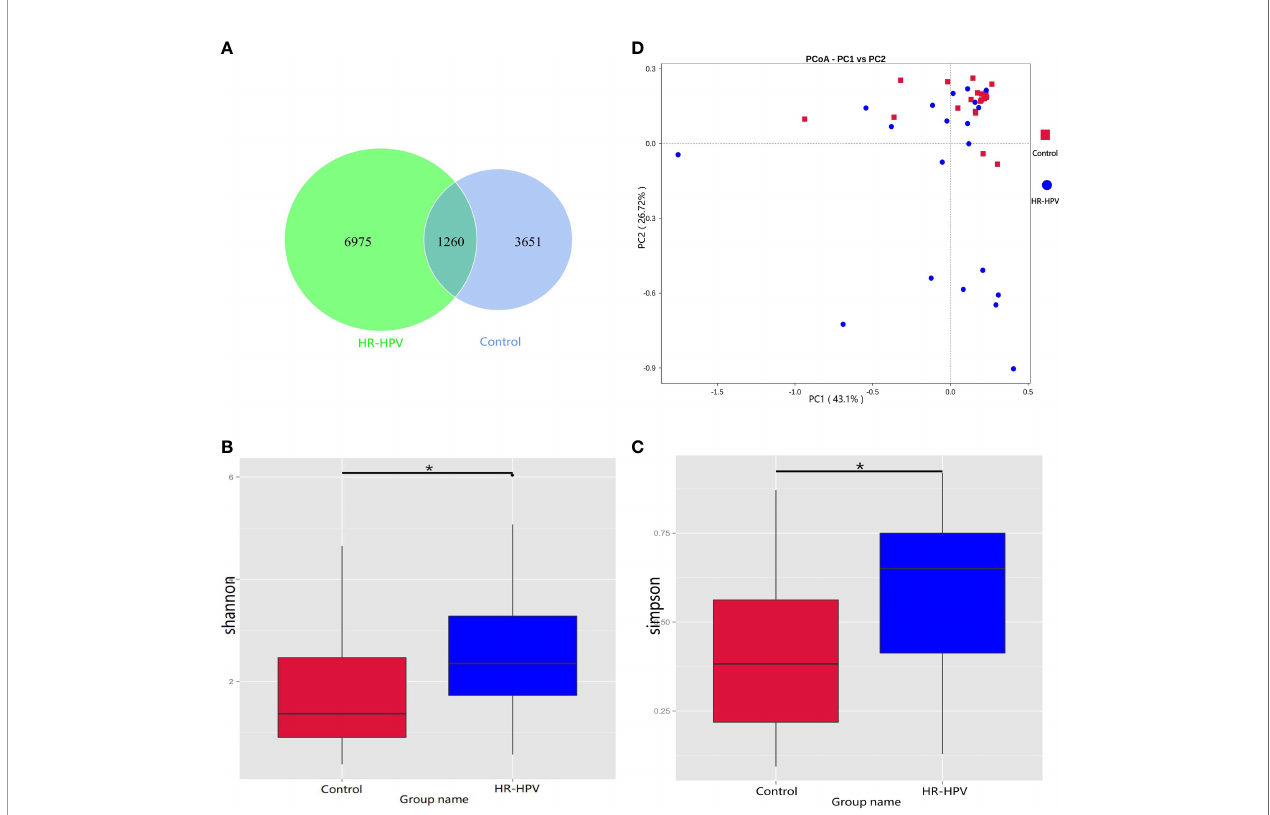
FIGURE 1 | 16S rRNA gene sequencing characteristics. (A) Venn graph of cervical microbiota between the two groups. (B, C) Comparison of the alpha diversity based on Shannon and Simpson indices between the two groups (* P < 0.05). (D) PCoA based on Weighted Unifrac